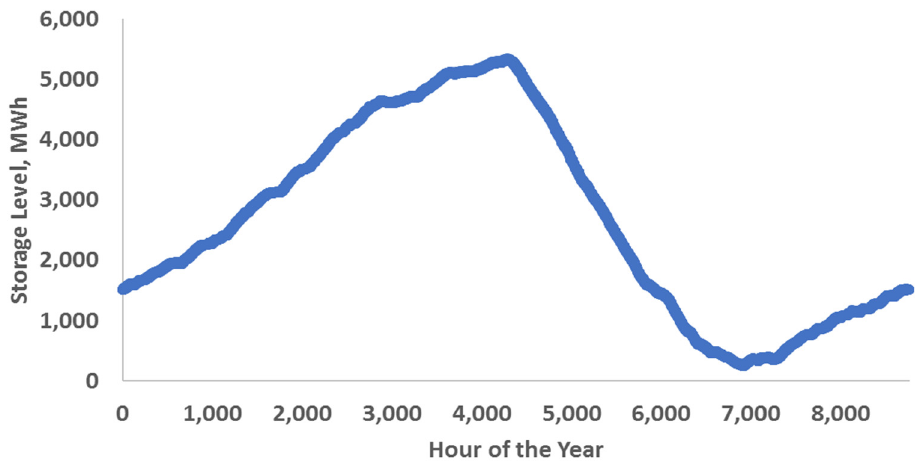
Figure 4. Hourly variation of energy storage levels throughout the year, in MWh.